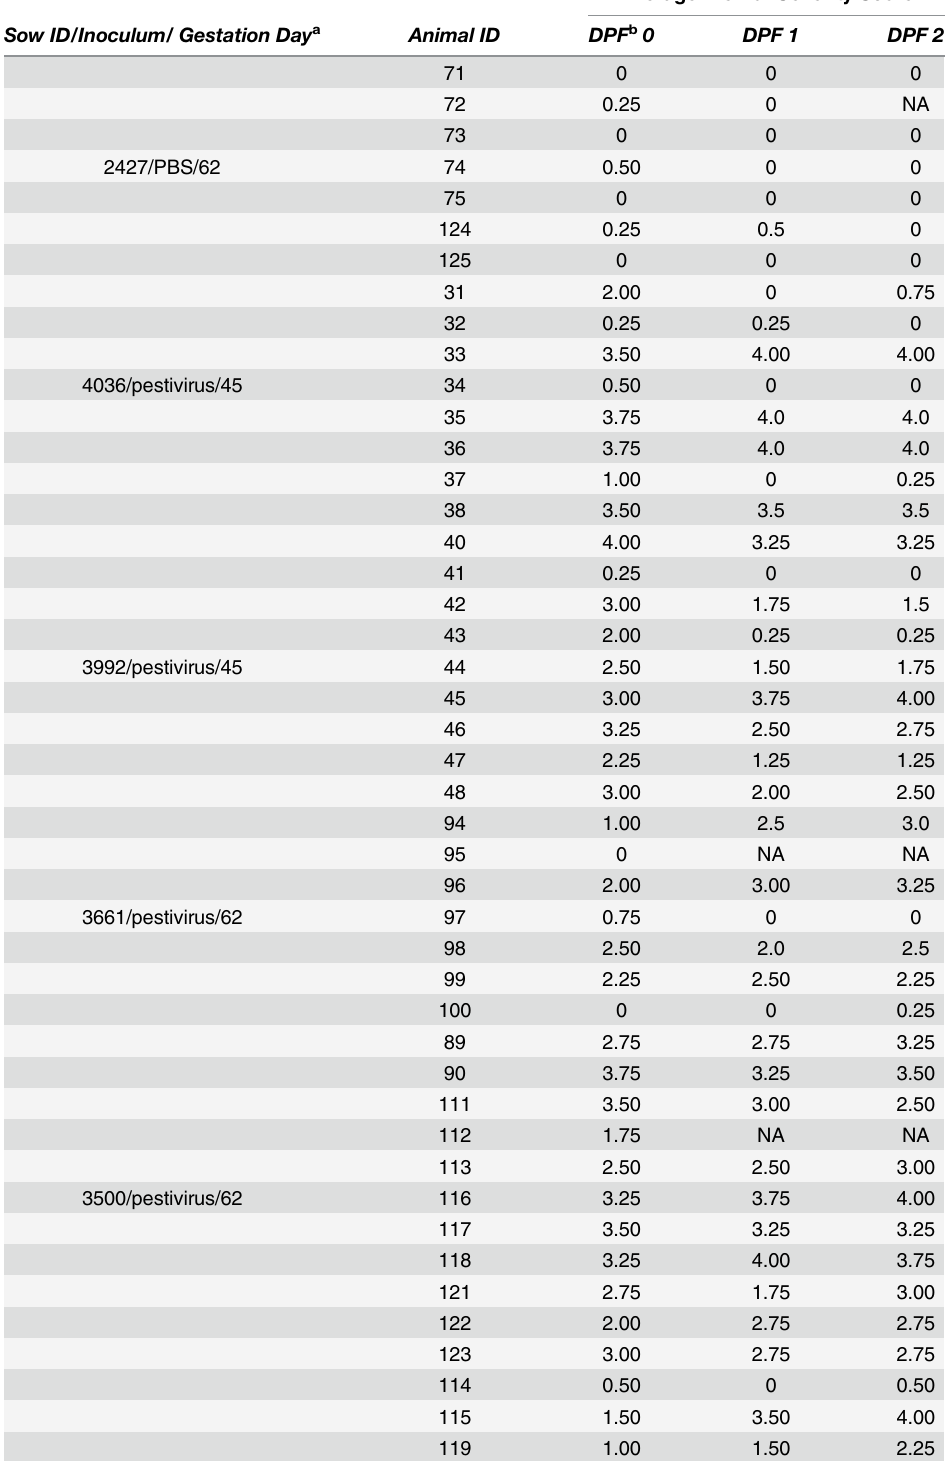
Table 4. Congenital Tremor Score by Piglet and Days